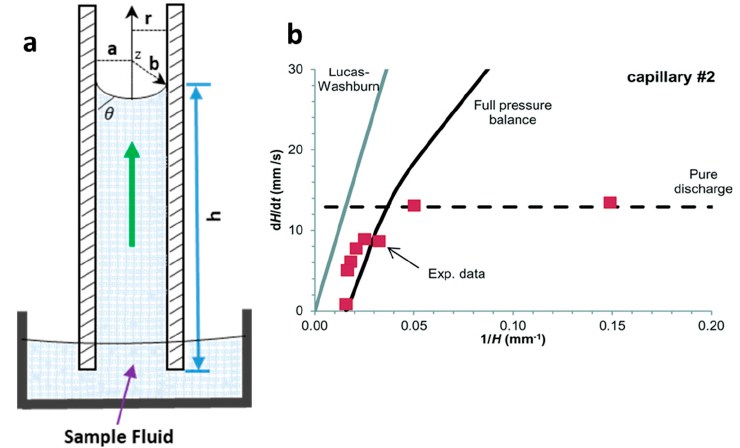
Figure 1. Capillary-driven flow dynamics. ( a ) Schematic of capillary-driven flow principle illustrating liquid rise in a capillary, height of the liquid rise ( ℎ ), meniscus and contact angle at the liquid − air interface ( 𝜃 ) and the radius of the capillary (r); ( b ) Superficial flow velocity (dH/dt) modelling using Equation (3) predictions at full pressure balance in the capillary. The Lucas − Washburn equation is unable to predict the liquid rise in the capillary due to the absence of gravitational effect in the equation. Reproduced with permission from [16].